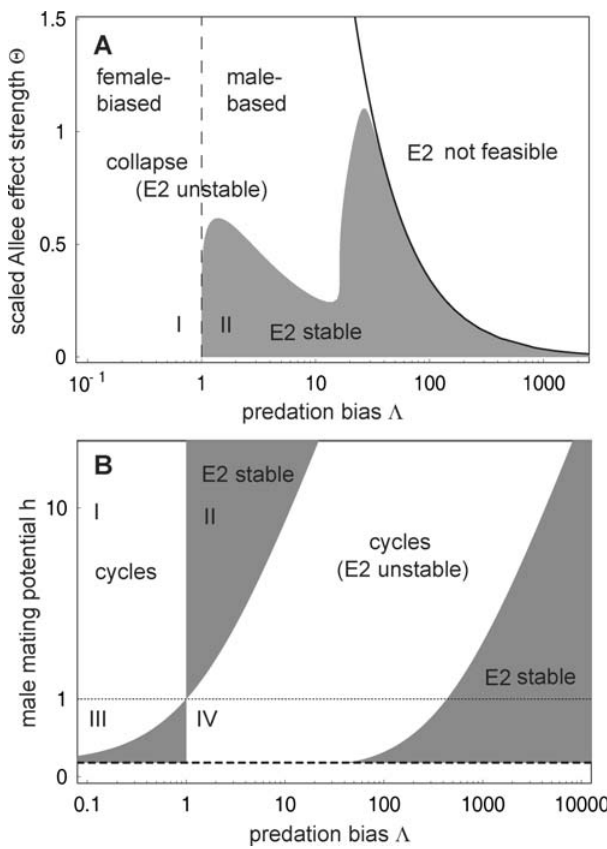
Figure 4. Stability of the predator-prey equilibrium E 2 in model (4). Common parameters: b =3, d =0.2, e 1 =0.2, e 2 =0.1, and M =1. A. Combined effect of predation bias and the Allee effect under unlimited polygyny. E 2 is feasible to the left of the solid black curve and locally stable within the grey area. B. Combined effect of predation bias and prey mating system with no Allee effect ( H =0). The equilibrium is feasible above h , 0.133 (dashed line) and locally stable within each grey area. Areas I–IV delimited by lines h =1 and L =1 correspond to Table 1.